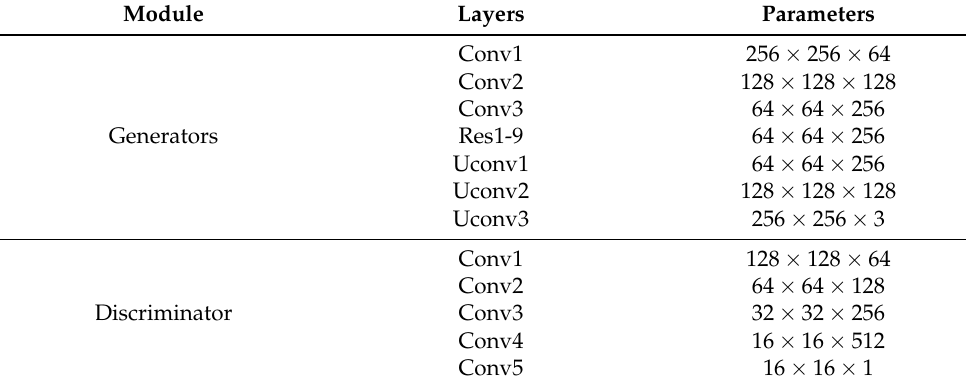
Table 1. An Overview of Network Configuration and Parameters. Module Layers Parameters